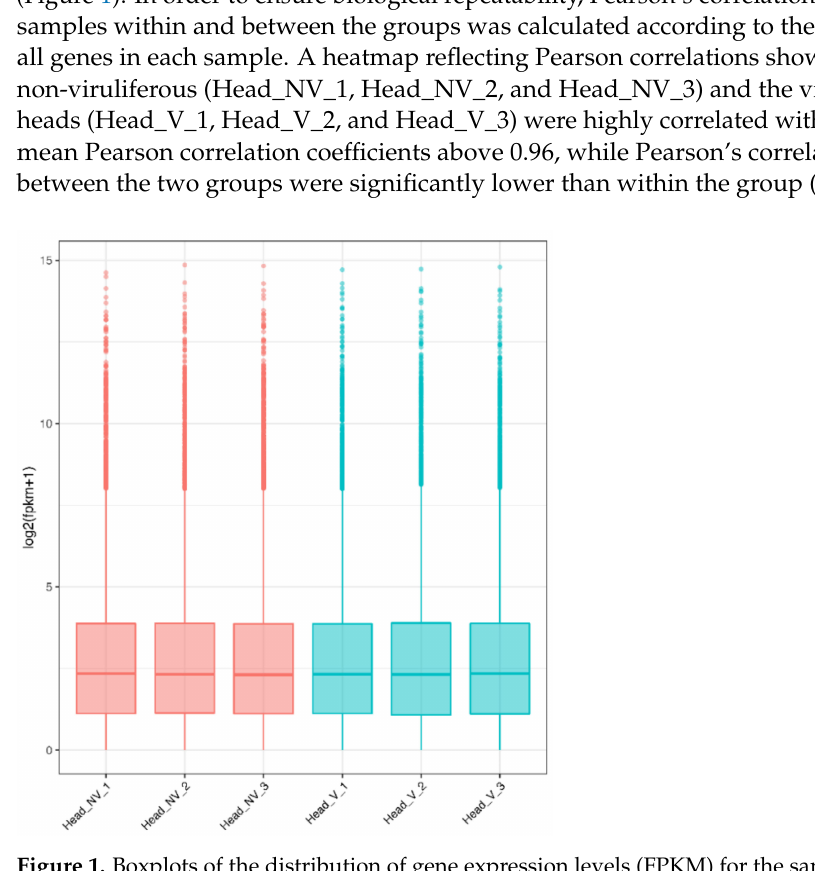
Figure 1. Boxplots of the distribution of gene expression levels (FPKM) for the samples of SBPH; the X-axis represents the names of the samples and the Y-axis represents the